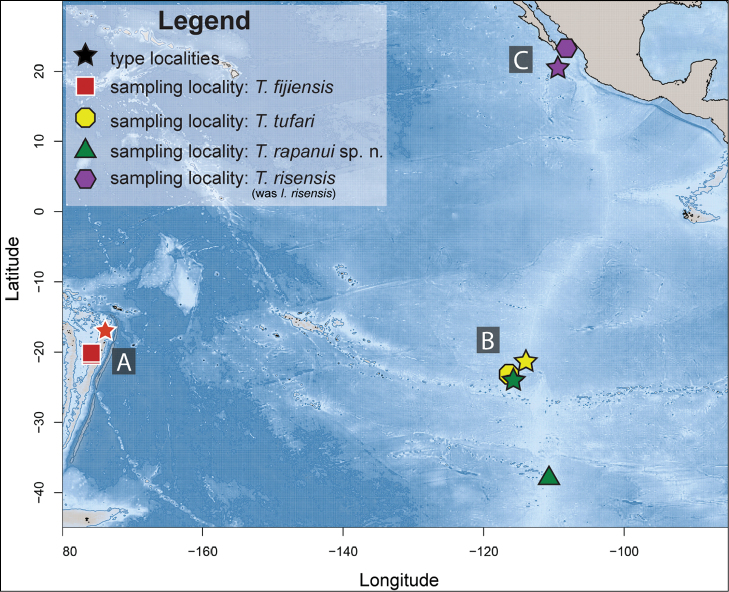
Map of sampling localities for iphionids in this study. Species differentiated by color and shape, type localities represented by stars. AThermiphionefijiensis type (star) and sampling (square) localities BThermiphionetufari type (star) and sampling (octagon) localities, as well as Thermiphionerapanui sp. n. localities (triangle) CThermiphionerisensis (was Iphionellarisensis) type (star) and sampling (hexagon) localities.